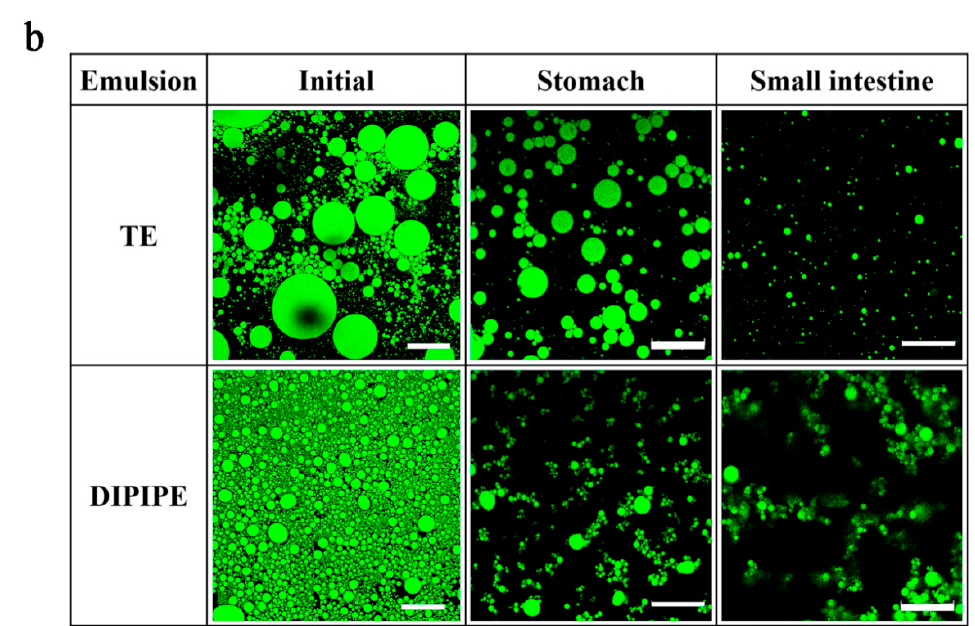
Figure 2. ( a ) Changes in the free fatty acid of β -carotene emulsion over time during simulated intestinal digestion. ( b ) Microstructure of the emulsion during in vitro simulated digestion (scale of initial emulsion = 100 μ m; scale of stomach and small intestine digestive juice = 50 μ m).